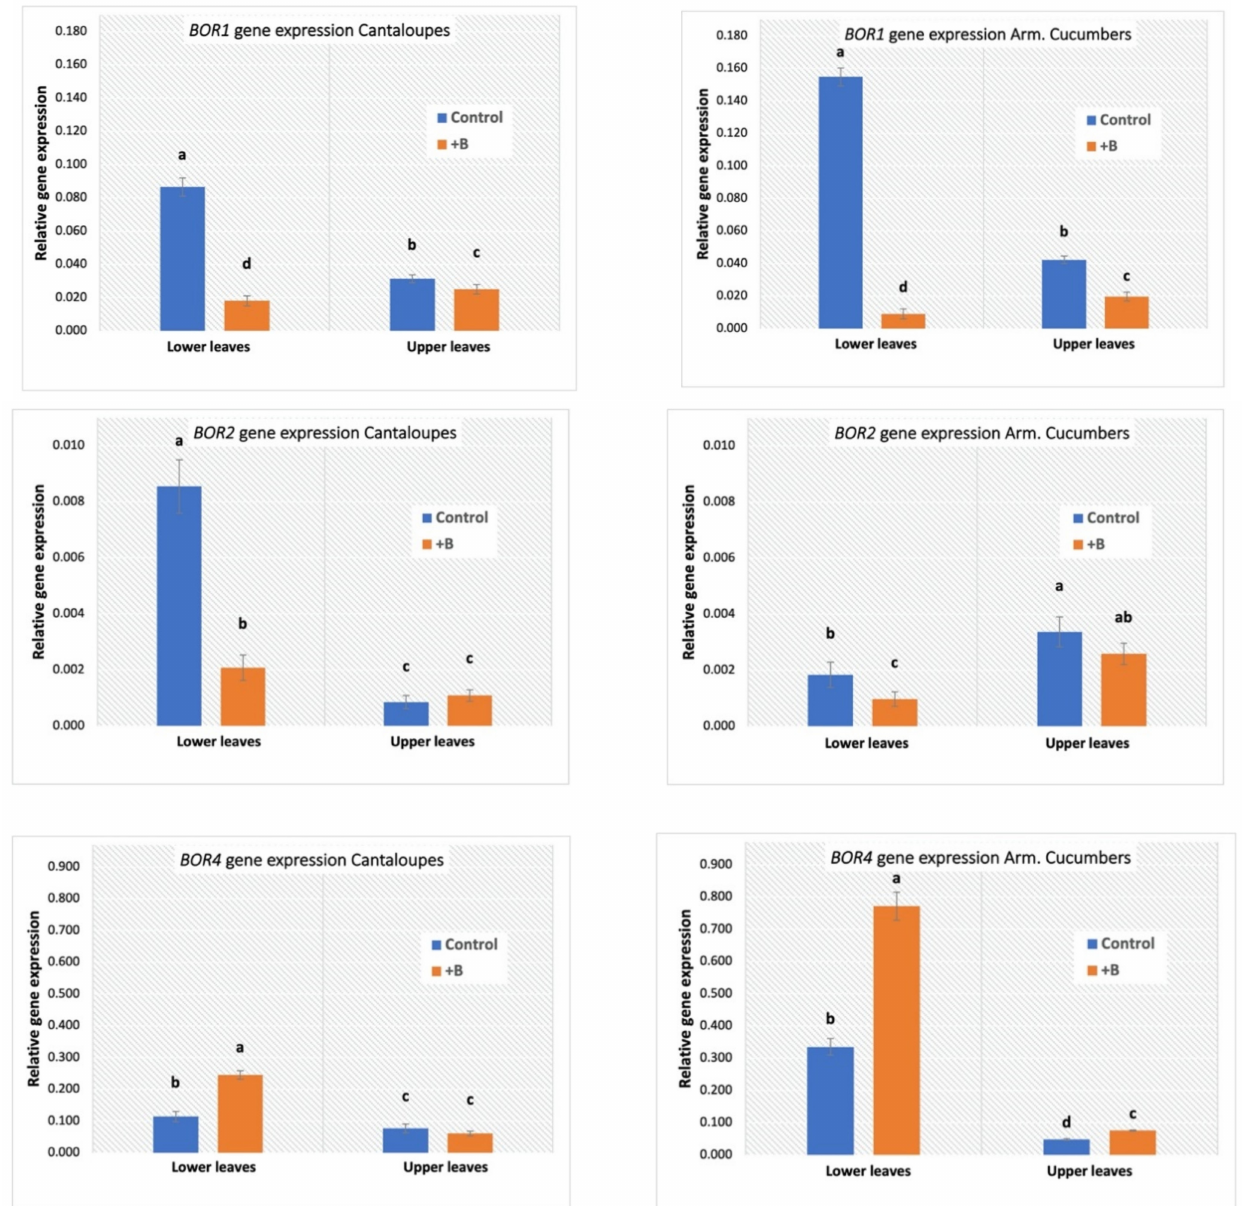
Figure 6. Effect of the oversupply of B (by using H 3 BO 3 ) on Boron efflux transporter ( BOR1 , BOR2 , and BOR4 ) transcription of young (close to the apical meristem) and mature (close to the root-to-shoot intersection) leaves of cantaloupes ( C. melo var. Cantalupensis cv. Retato Degli Ortolani) and Armenian cucumbers ( C. nelo var. flexuosus cv. Abruzzese Tortarello). COX was used as a reference gene. Growth period lasted 35 d, where no visible B toxicity symptoms were apparent (Figure 1). Means followed by different letters indicate significant differences ( p = 0.05). Values are the mean of ten replications ( ±